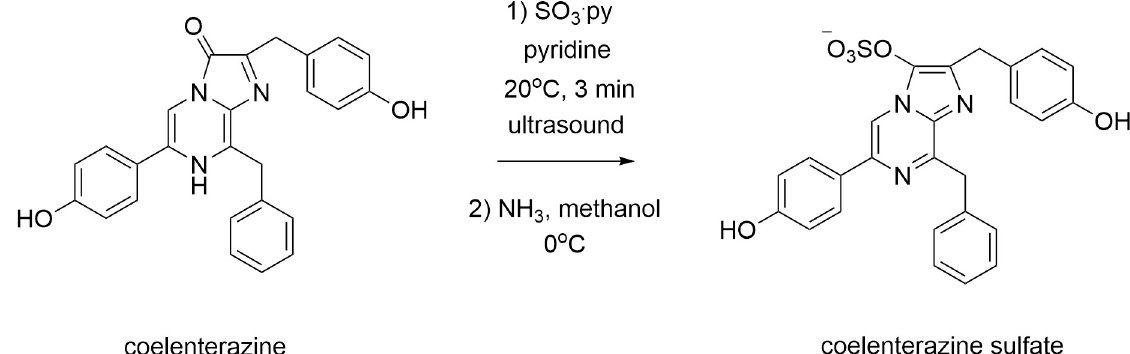
Fig 4. Scheme for coelenterazine sulfate chemical